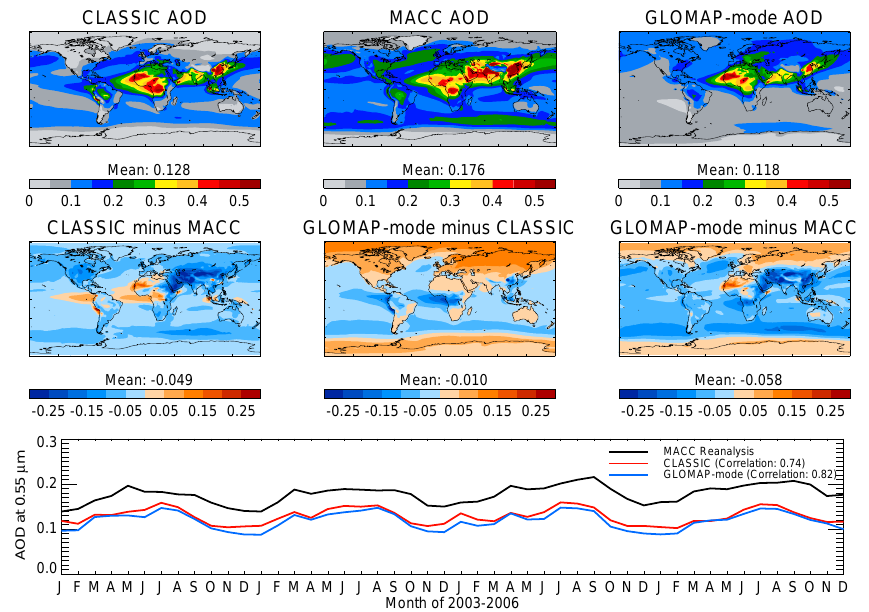
Fig. 2. Top row: total aerosol optical depth (AOD) at 0.55µm for the period 2003–2006 in, from left to right, HadGEM using the CLASSIC aerosol scheme, the MACC aerosol re-analysis, and HadGEM using the GLOMAP-mode aerosol scheme. Middle row: differences between, from left to right, CLASSIC and MACC, GLOMAP-mode and CLASSIC, and GLOMAP-MODE and MACC. Bottom row: timeseries of global, monthly-averaged aerosol optical depth at 0.55µm in the MACC aerosol re-analysis (black), CLASSIC (red), and UKCA-MODE (blue) for